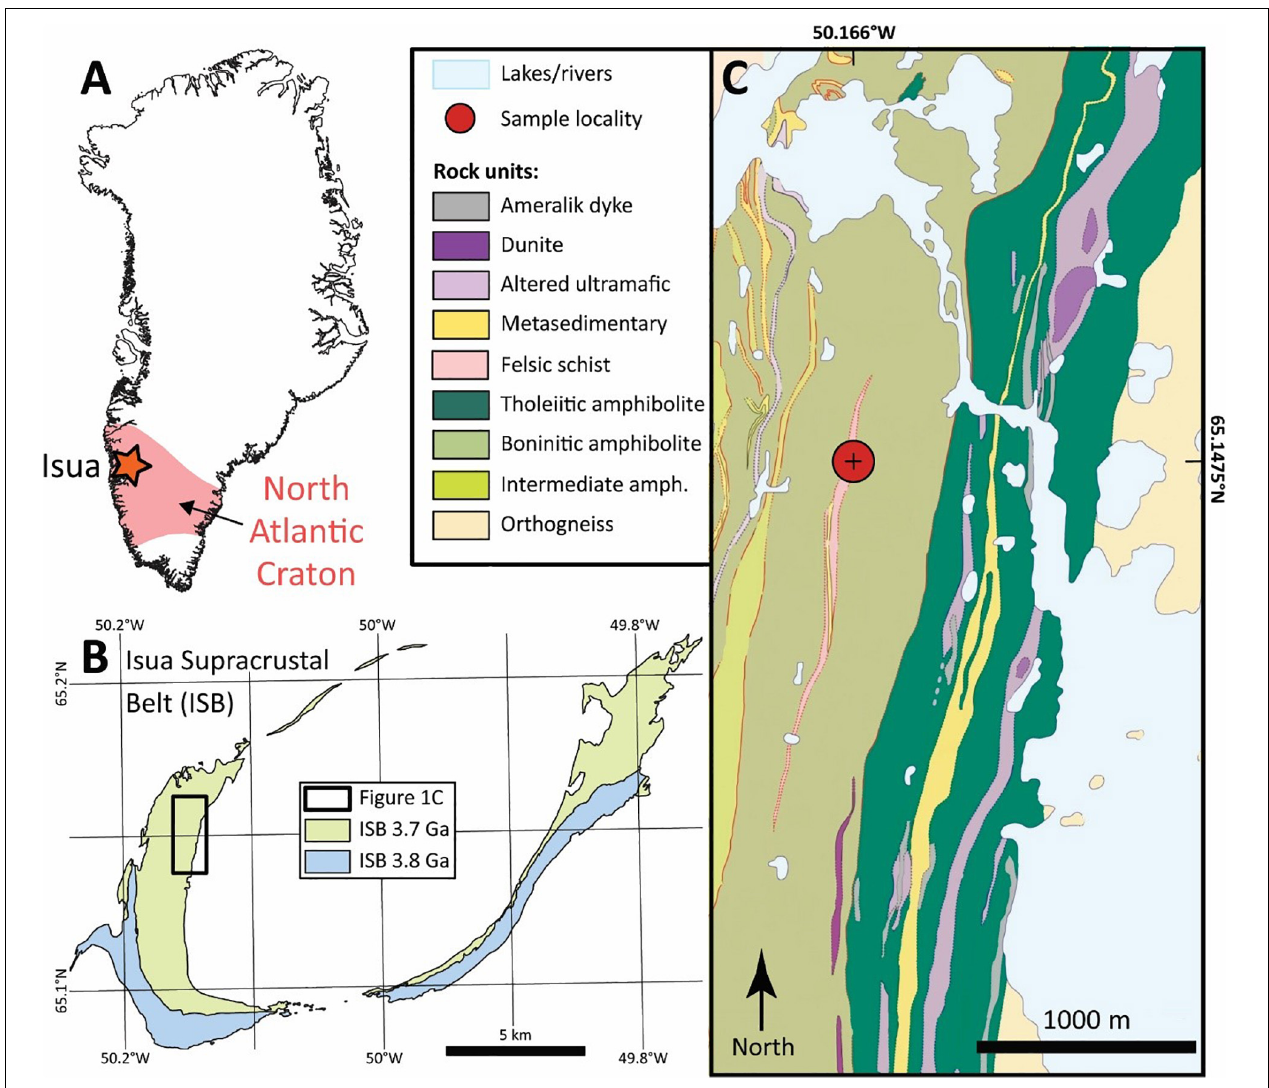
FIGURE 1 | Geological map of the Isua Supracrustal Belt. (A) Shows the extent of the Archean North Atlantic Craton in Greenland, with the position of Isua marked by the star. (B) Overview map of the Isua Supracrustal Belt, with the two distinct sequences shown in blue and green colors. The study area is outlined by the box. (C) Detailed geological map of the locality from which the samples of the present study were collected. Modified after and Nutman and Friend (2009) and Waterton (submitted).